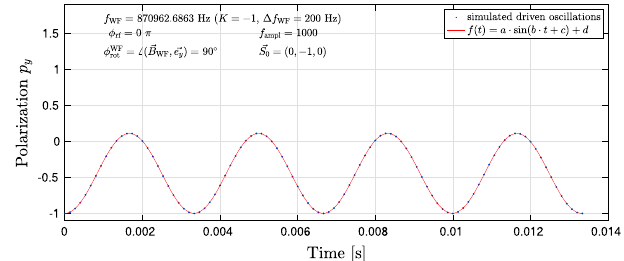
FIG. 6. Off-resonance driven oscillations with Δ f in Eq. (51) for the conditions of Table I.